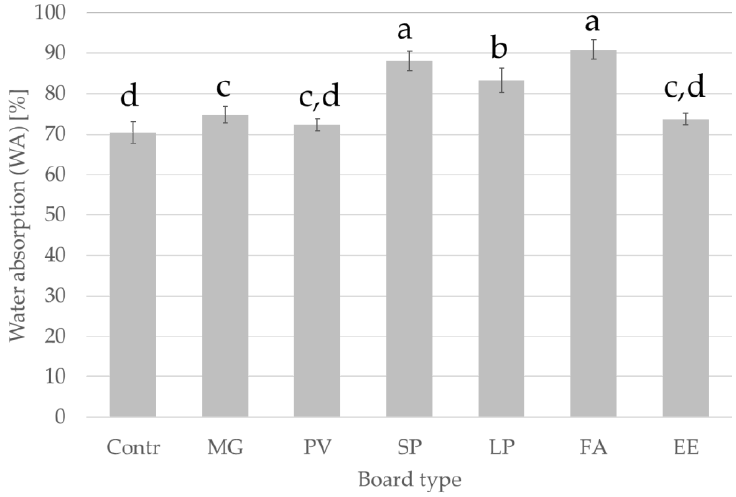
Figure 6. Water absorption of manufactured panels after 24 h. Abbreviations used: contr. — control